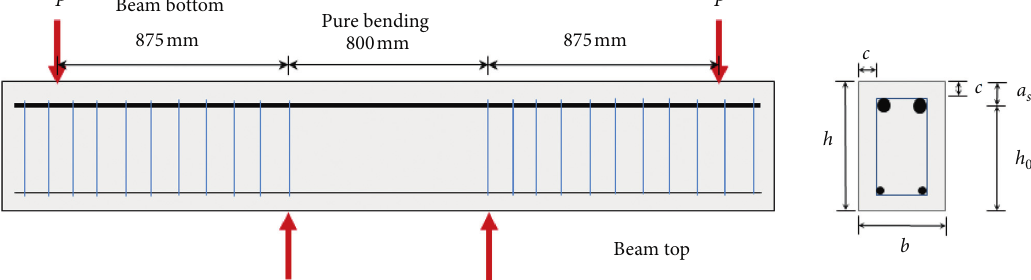
Figure 1: Geometry of RC beams.